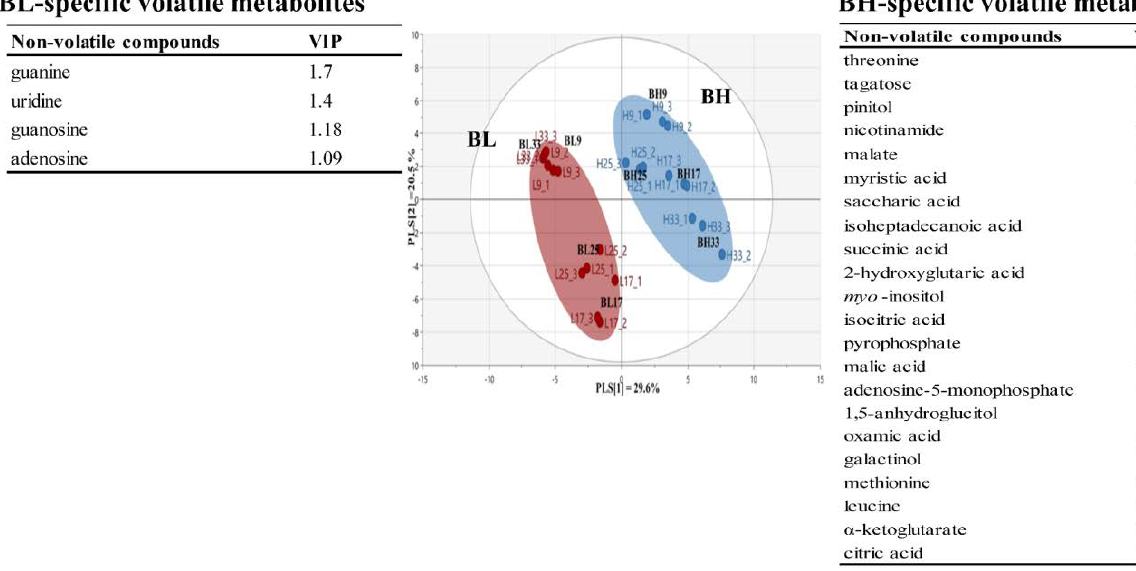
Figure 3. Multivariate statistical model by PLS-DA score plot based on non-volatile metabolite profiles, and the list of main variables representing BH or